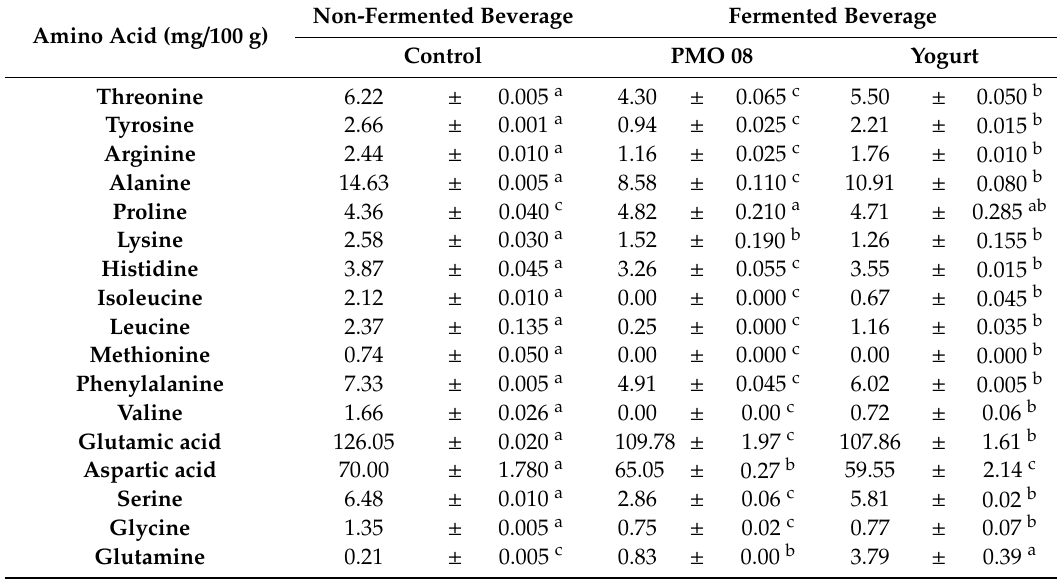
Figure 4. Changes in the total polyphenol content and antioxidant activity during fermentation. ( A ) Total polyphenol content. Values are represented as the mean of three replicates and error bars represent the standard deviation. ( B ) 1,1-Diphenyl-2-picrylhydrazyl radical scavenging activity. Control: Non-fermented tomato juice beverage; PMO 08: Tomato juice fermented by L. plantarum PMO 08; Yogurt: Tomato juice fermented by yogurt starter culture containing Lactobacillus acidophilus, concentration (v / v); 2nd column (green), 5% of each beverage concentration (v / v); 3rd column (red), 10% of each beverage concentration (v / v). Each of the beverages was diluted with purified water. Di ff erent uppercase letters denote significant di ff erences between di ff erent concentrations of the same type of fermented beverage. Di ff erent lowercase letters denote significant di ff erences between the three types of fermented beverages ( p < 0.05). Table 2. Changes in the free amino acid composition of fermented